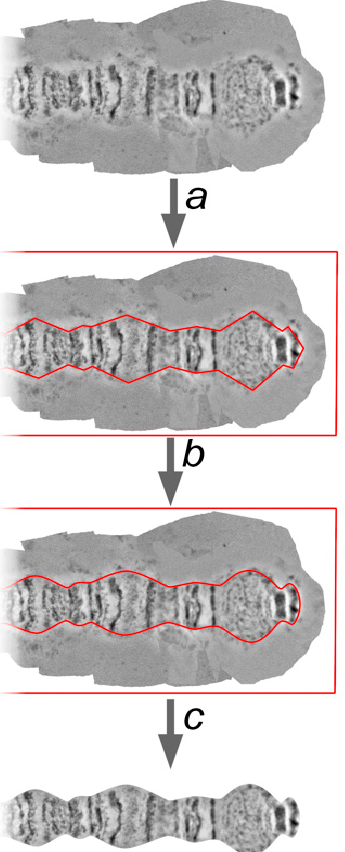
Figure 7. Trimming of a chromosome arm map (the pericentromeric region of 3R arm of An. beklemishevi nurse cells as an example): a—making the path, using “Path Tool”, and marking protuberances and hollows of chromosome edge profile (red line); b—smoothing angles using “Convert Point Tool” (red line); and, c—making the selection from the path and deleting the background area.